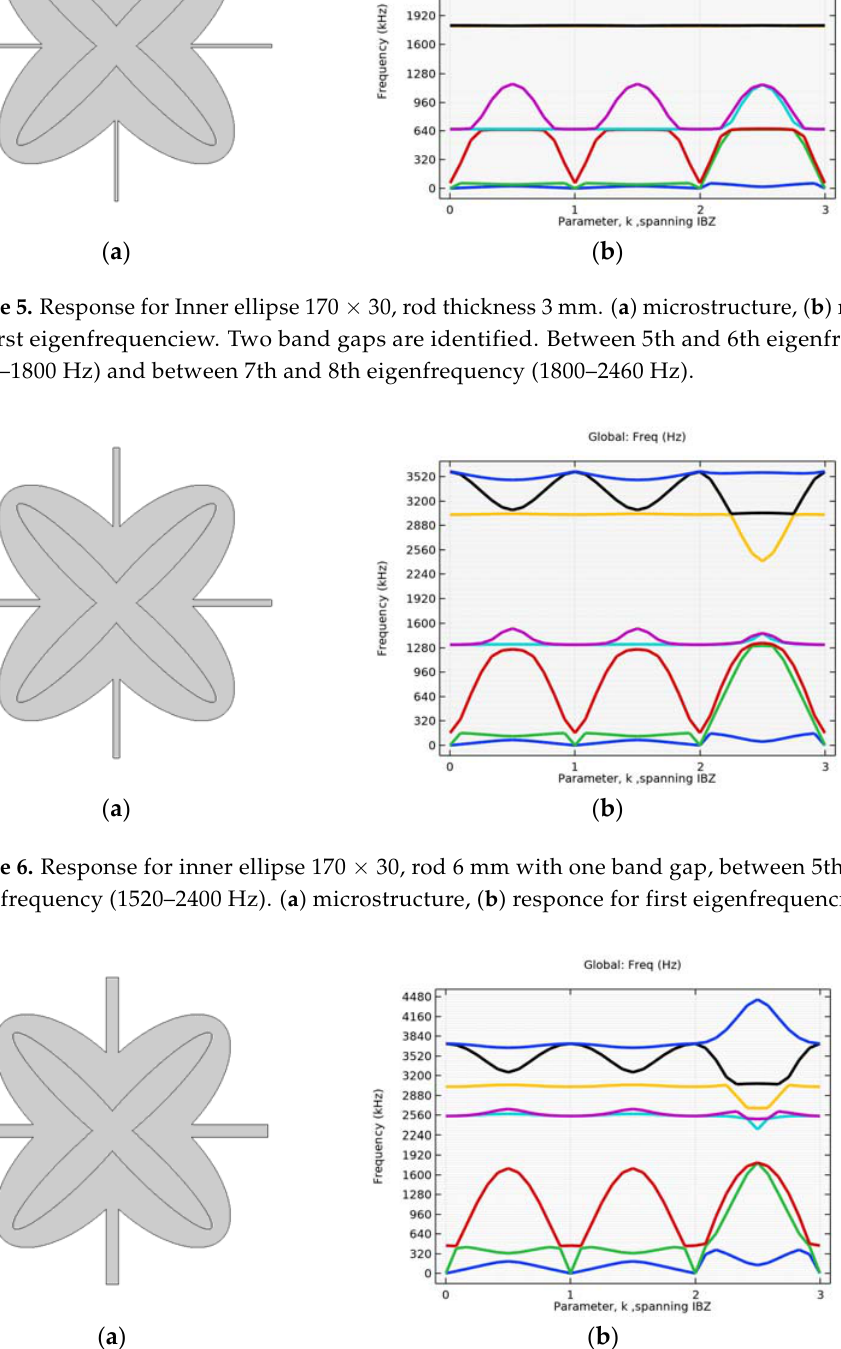
Figure 7. Response for inner ellipse 170 × 30 and rod thickness 12 mm. (a) microstructure, (b) responce for first eigenfrequenciew. Two band gaps between 3rd and 4th eigenfrequency (1720–2320 Hz) and a marginal between 5th and 6th eigenfrequency (2680–2700 Hz).